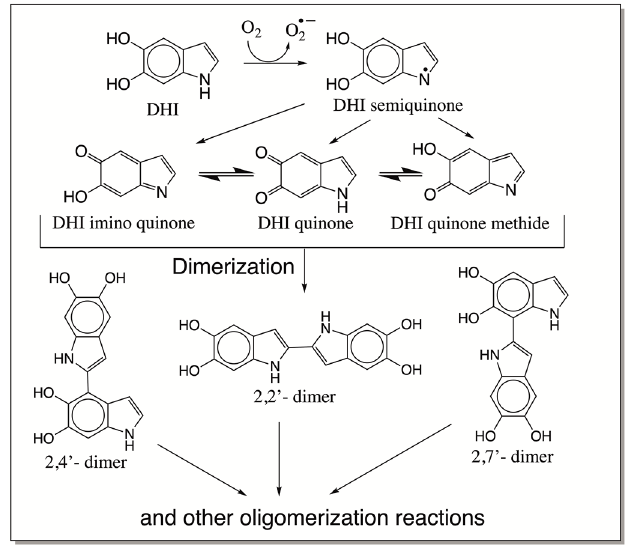
Figure 13. Proposed mechanism for the oxidative polymerization of DHI. DHI undergoes rapid aerial oxidation, producing DHI semiquinone radicals and the superoxide anion. Two molecules of DHI semiquinones undergo a redox reaction, regenerating DHI and producing the two-electron oxidation product that can exist in three different isomeric forms. Rapid condensation of these products generates dimeric, trimeric, and other oligomeric products at initial stages of oxidation. Eventually, they all condense and form insoluble black-colored eumelanin pigment.